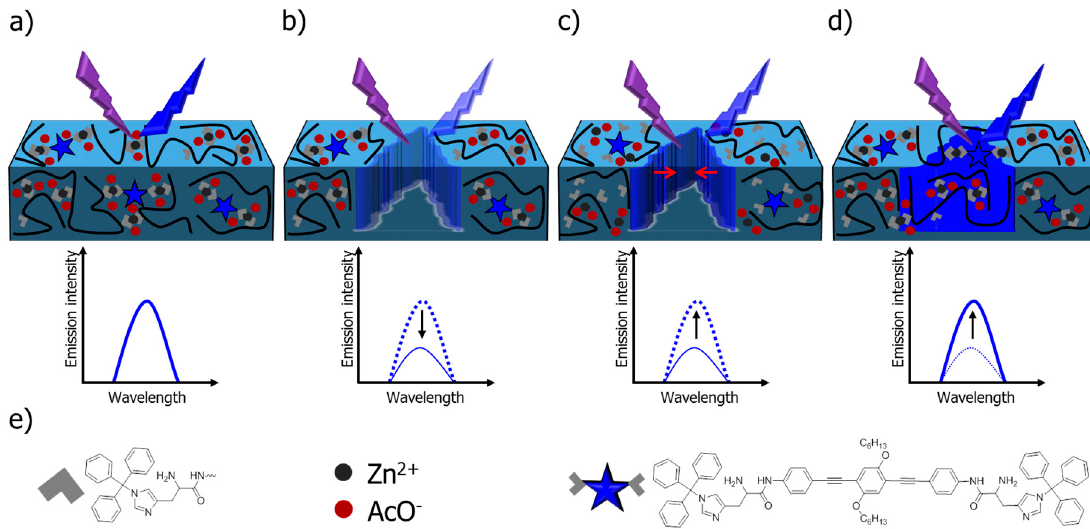
Figure 6. Schematic representation of the utilization of the emission of a sensor molecule (bottom right) for the monitoring of the healing process of supramolecular polymers. ( a ) The original material features a certain emission of light, ( b ) which is destroyed by a damage. ( c ) During the healing process, ( d ) the emission can be recovered until a complete healing is obtained. Reprinted with permission from [108]. Copyright 2018 American Chemical Society.